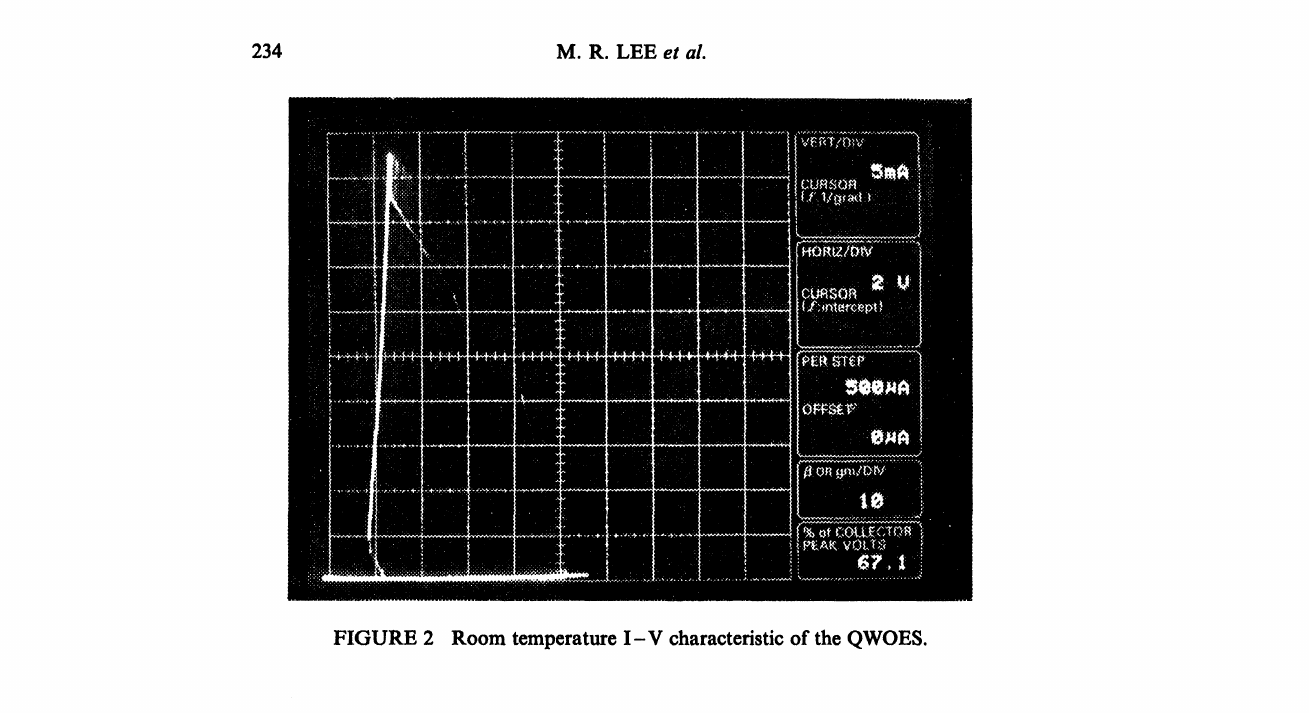
FIGURE 2 Room temperature I-V characteristic of the